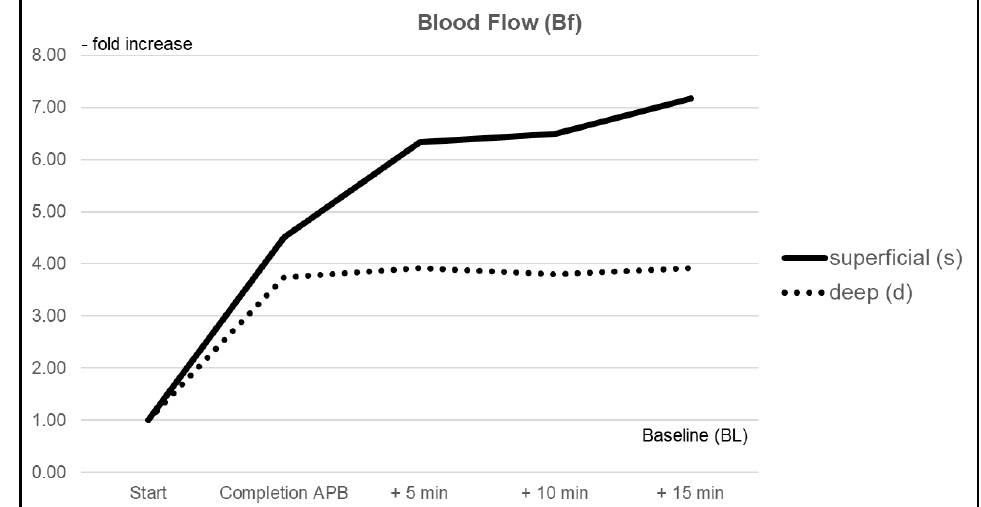
Figure 2. Relative changes in mean blood flow (Bf) within superficial (pulp) and deep (thenar eminence) tissue layers over the duration of the investigation.